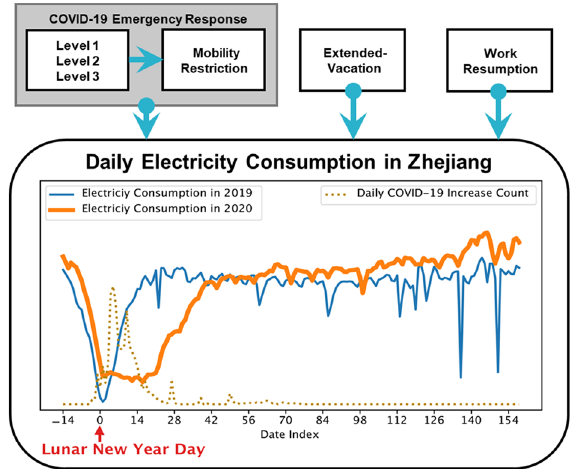
Figure 1. The daily electricity consumption during the COVID-19: the figure compares the actual daily electricity consumption in eastern China in 2020 to itself in the same matched lunar calendar period in 2019. The horizontal axis represents the date index, and day 0 represents the Lunar New Year day (2020: Jan 24th; 2019: Feb 4th). The dashed line is the daily COVID-19 increase cases in eastern